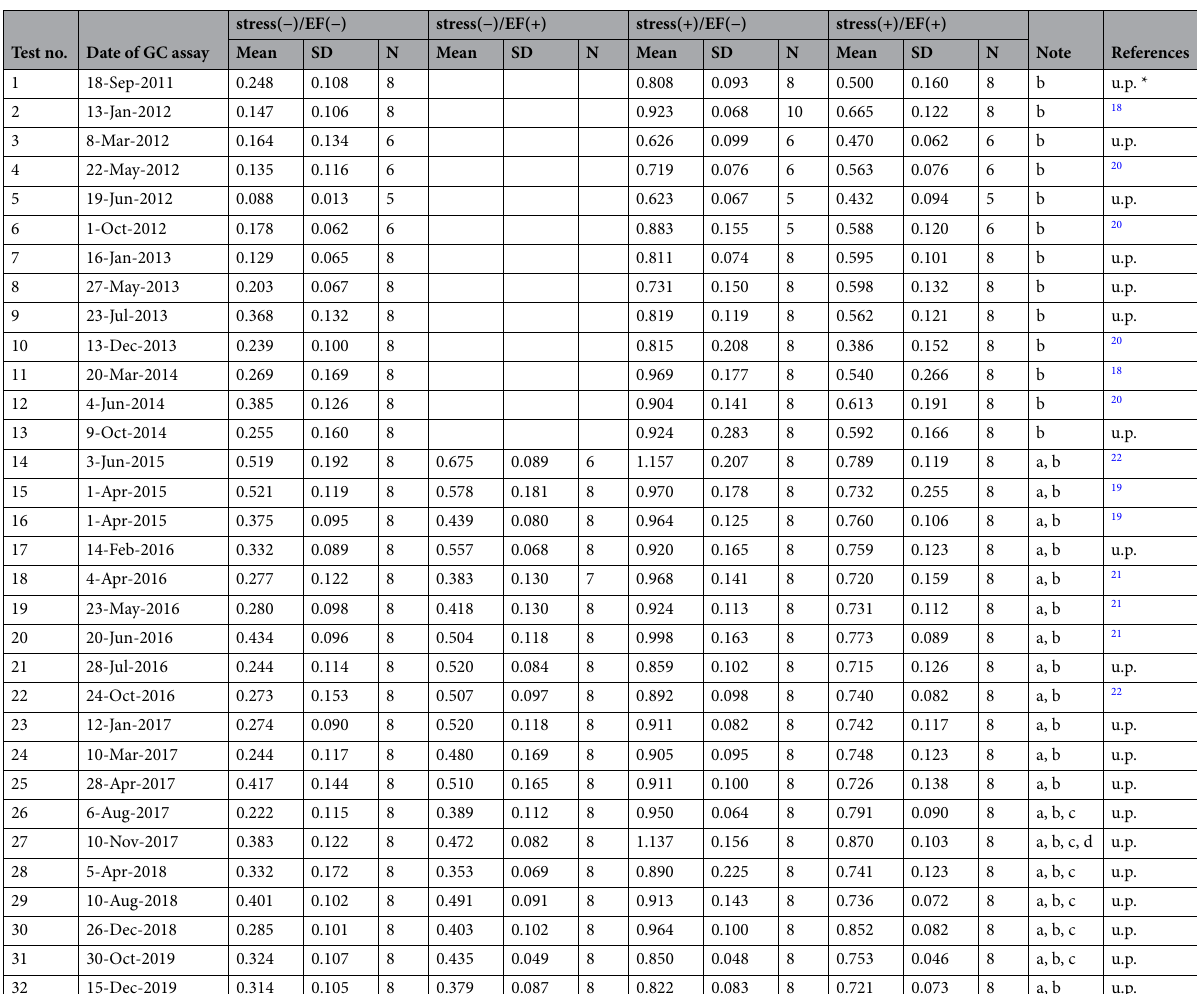
included the four standard groups are from 2014 (Test Nos. 14-32).